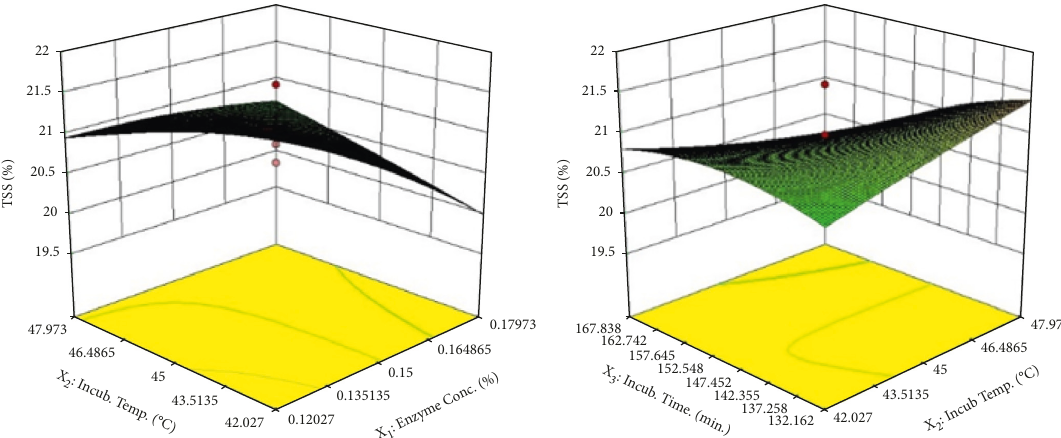
Figure 4: 3D graph plots displaying the linear and interactive effect of factors on TSS.